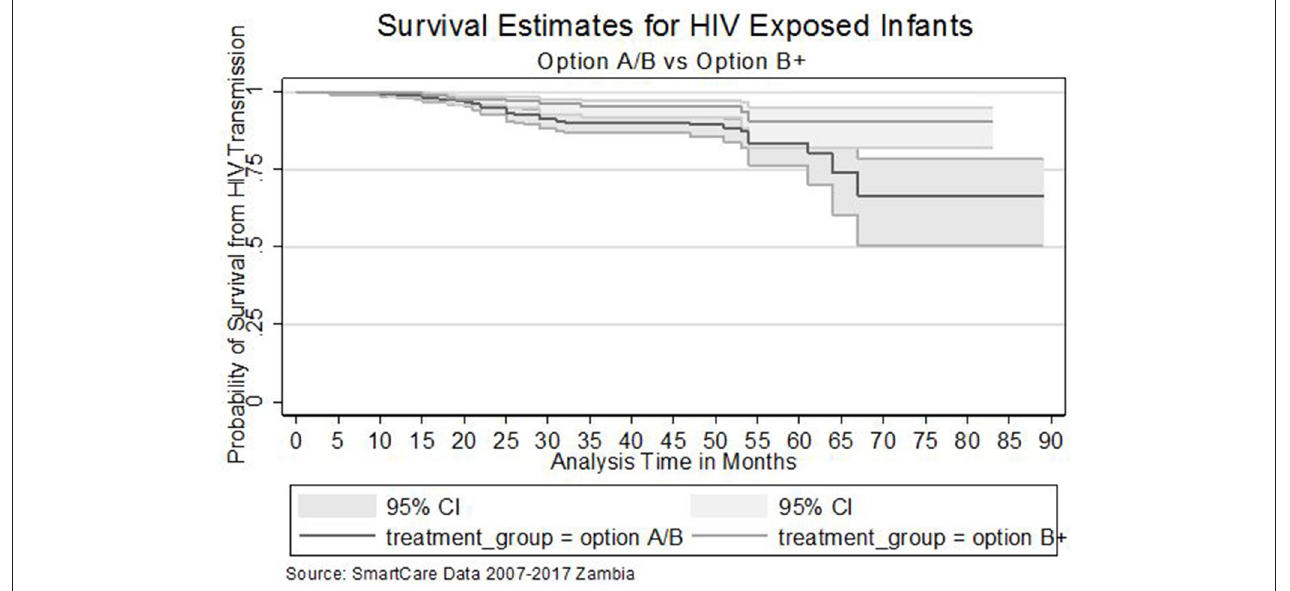
FIGURE 1 | Comparison of survival estimates between exposed infants of HIV positive mothers on option A/B and Option B + . (a) Zambia introduced lifelong Option B + for HIV positive mothers mid 2013. (b) Prior to 2013, HIV positive mothers with CD4 count < 350 cells/ ml were put on Option A/B.